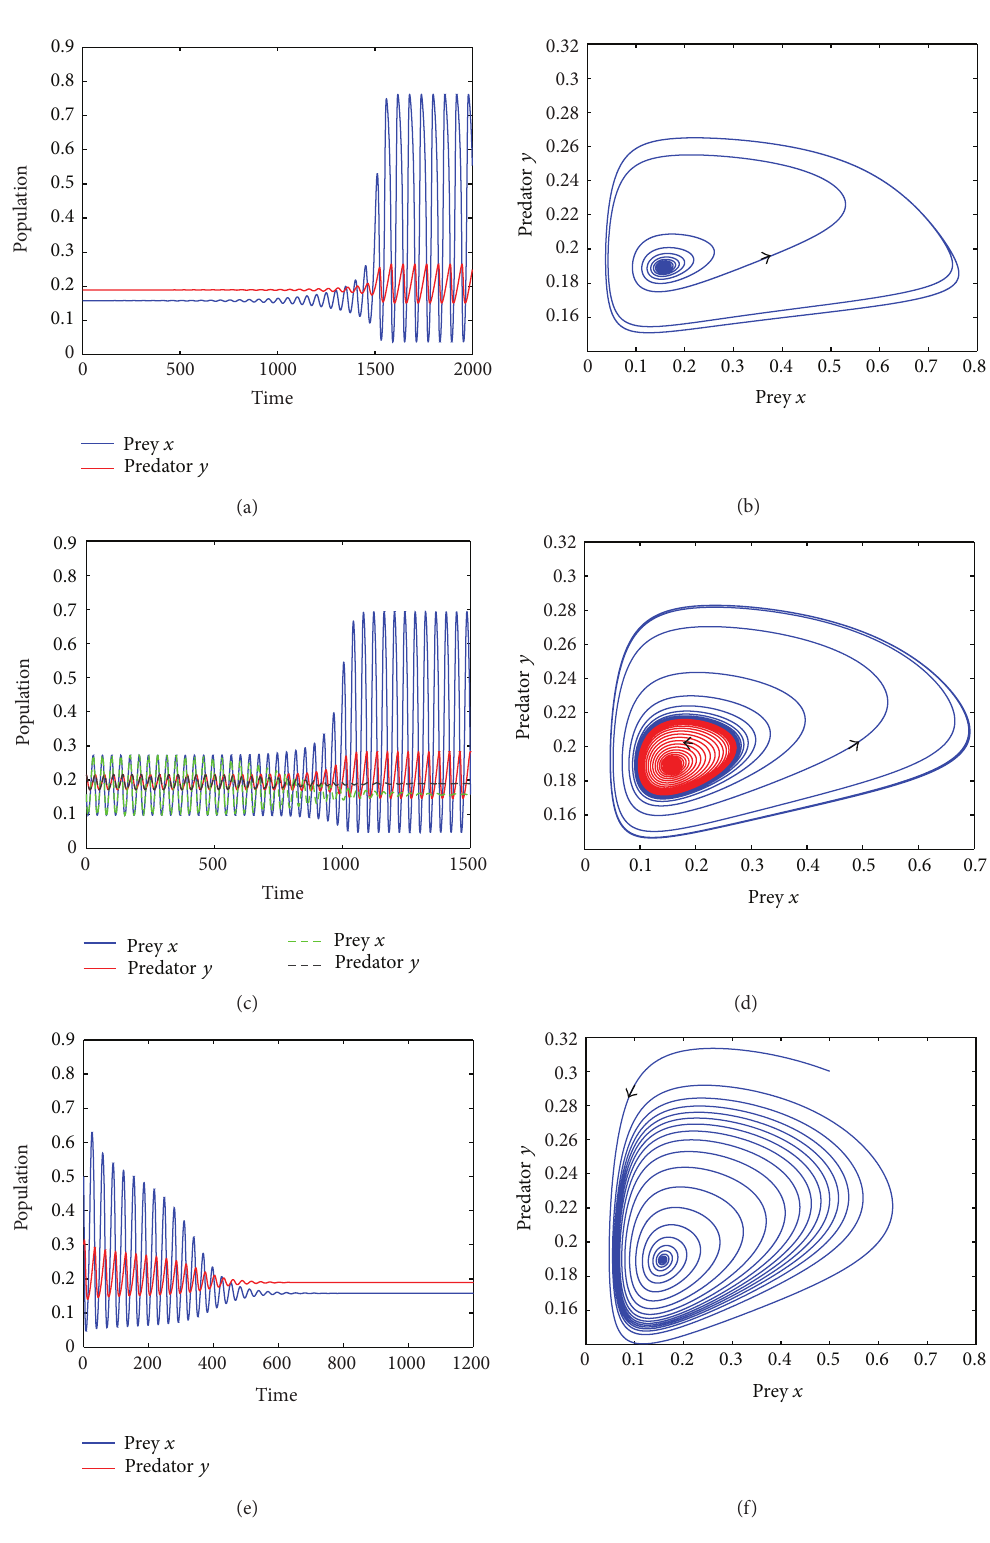
Figure 5: The trajectory graphs and phase portrait of system (7) without delay for (𝛼, 𝛽) ∈ 𝐷 2 with 𝛼 = 0.2 and 𝛽 = 1.2 . (a)-(b) 𝛾 = 0.02 < 𝛾 0 . Thepositiveequilibrium 𝐸 ∗ isunstablewithalarge-amplitude stableperiodicorbit.Theinitialvalueis (0.1578, 0.18935) . (c)-(d) 𝛾 = 0.04 > 𝛾 0 . The positive equilibrium 𝐸 ∗ is stable, and a small-amplitude unstable periodic solution and a large-amplitude stable periodic solution coexist. The initial values are (0.1578, 0.21532) and (0.1578, 0.21533) . (e)-(f) 𝛾 = 0.06 > 𝛾 0 . The positive equilibrium 𝐸 ∗ is stable and there are no Hopf bifurcating periodic orbits. The initial value is (0.5,0.3)